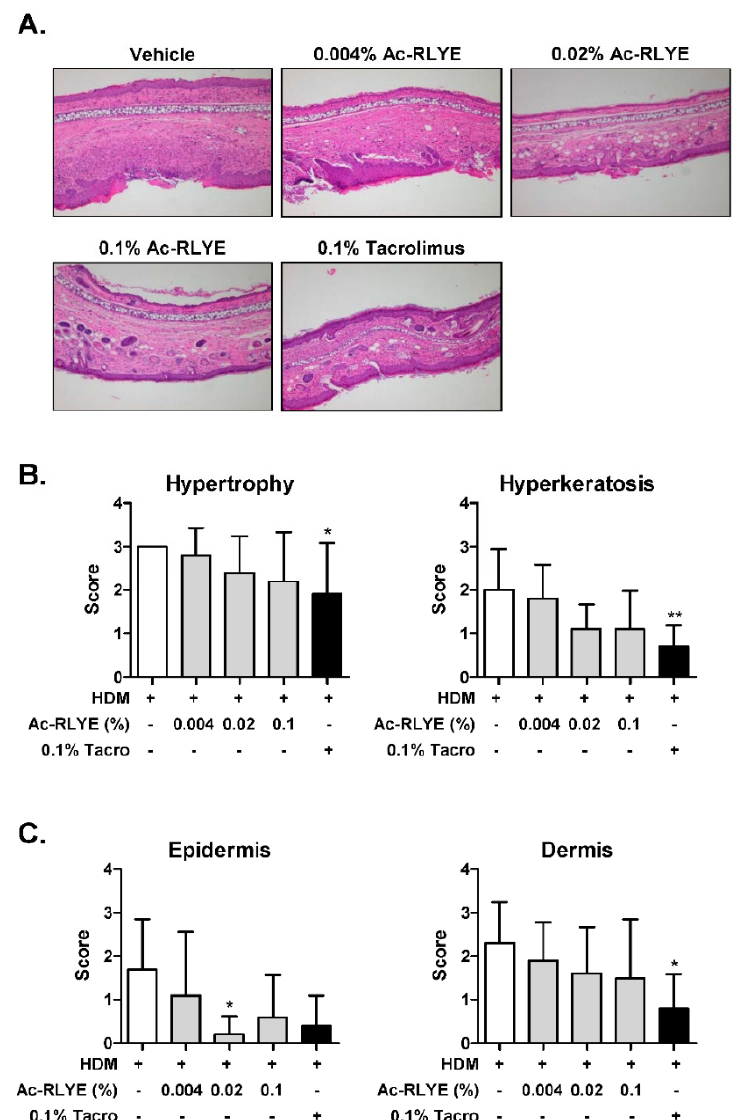
Figure 3. Topical application of Ac-RLYE reduces tissue inflammation in NC/Nga mice. ( A ) Mi- crophotographs of ear sections isolated at Day 48 and stained with H&E. ( B ) The scores of hypertrophy and hyperkeratosis were evaluated. ( C ) The scores of infiltration of inflammatory cells in epidermis and dermis of AD-like skin lesions of NC/Nga mice were evaluated. Data are presented as mean ± SD values for each group ( n = 10). * p < 0.05, ** p < 0.01 in comparison to vehicle-treated group.